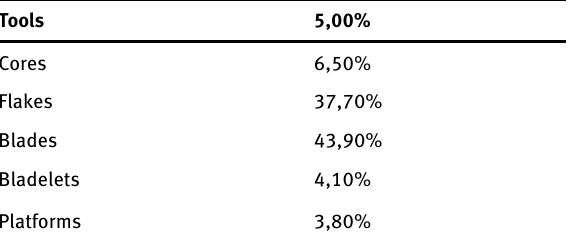
Table 3. Lipari, Contrada Diana trench XVII. Synthesis of obsidian artifacts.